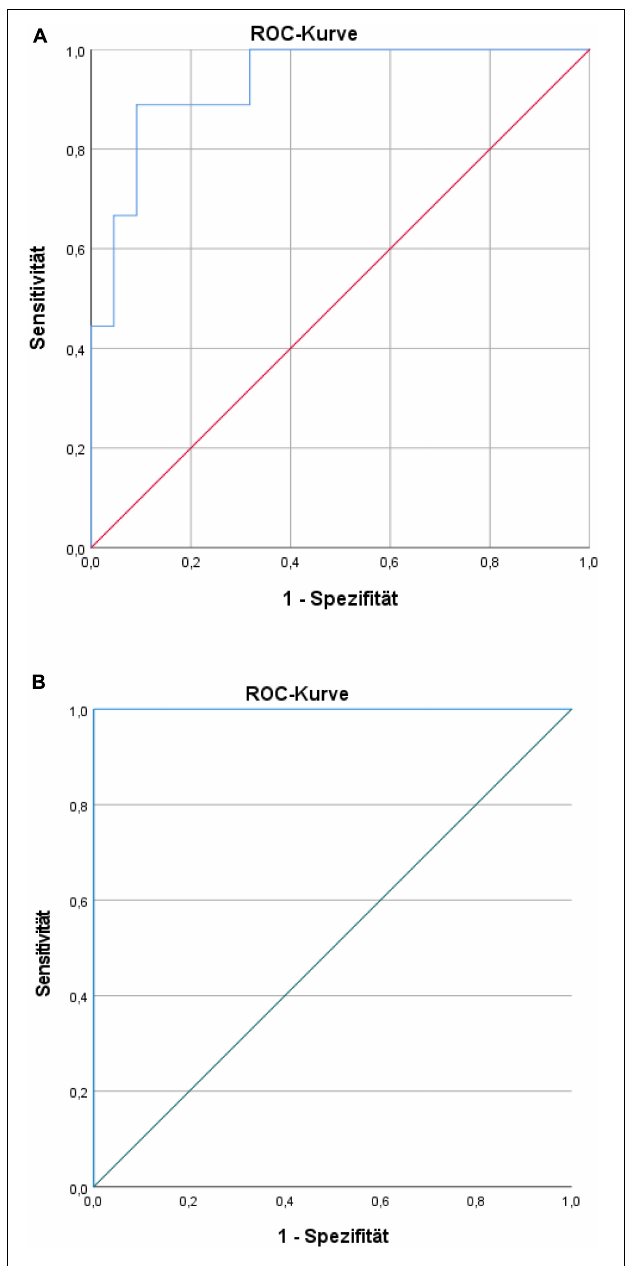
FIGURE 5 | (A) Receiver-operating characteristic (ROC) curve for characteristic pain intensity prediction of the biomarker set. (B) ROC curve for pain disability prediction of the biomarker